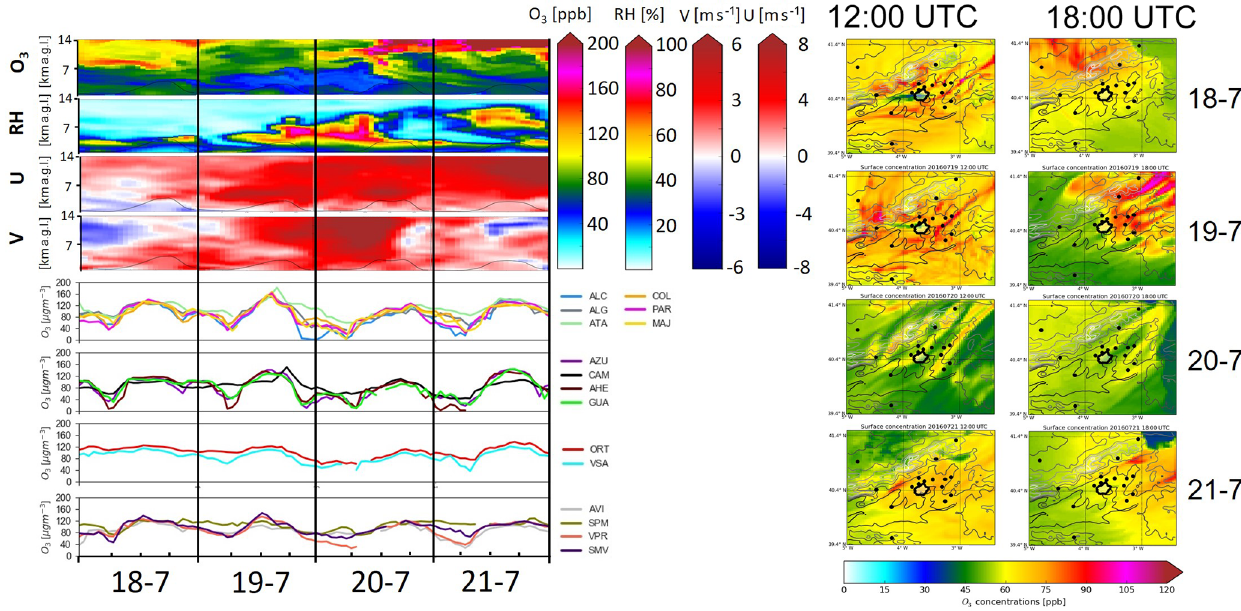
Figure 9. Left: hourly O 3 concentrations recorded at selected monitoring stations in the MAB and simulated fields of O 3 concentration, rela- tive humidity, and U and V components of wind for the period 18–21 July 2016 over the centre of the MAB. Right: surface O 3 concentration maps obtained from LOTOS-EUROS simulations at 12:00 and 18:00UTC of 18, 19, 20 and 21 July 2016 in the MAB. See Fig. 1 to consult the location and typology of the selected